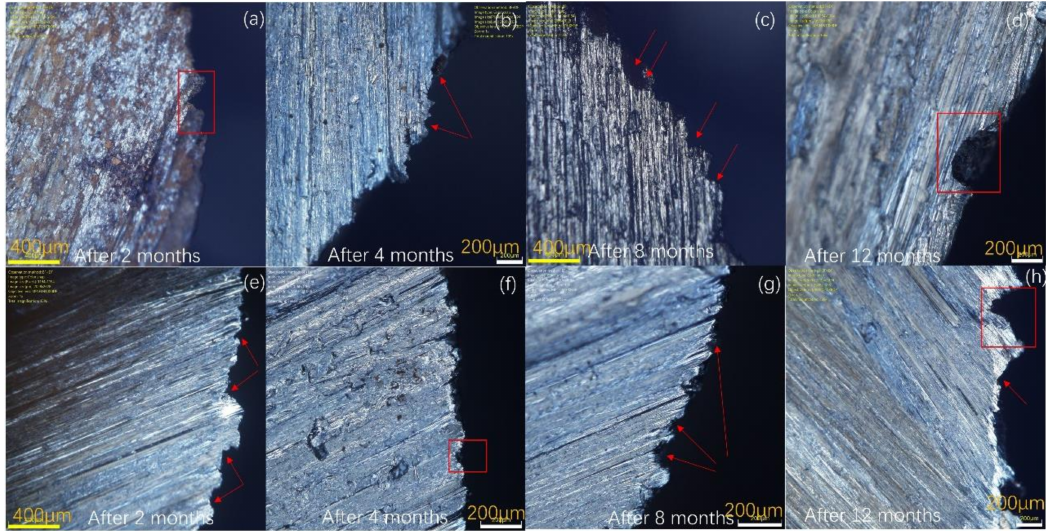
Figure 11. Cross-section pits in rebar after 2, 4, 8, and 12 months of immersion, observed under a microscope with arrows and boxes indicating localized attack: ( a – d ) 615; ( e – h ) 9% Cr